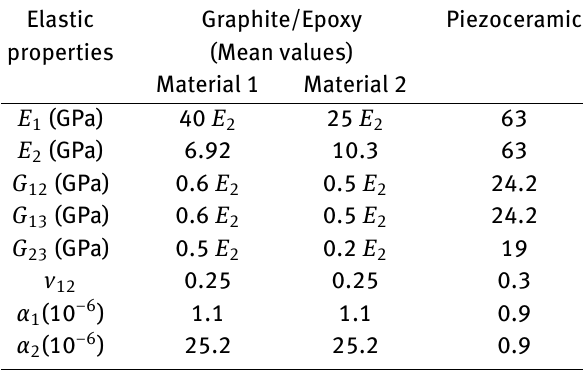
Table 1: The following elastic properties of materials used for com- putation of numerical results